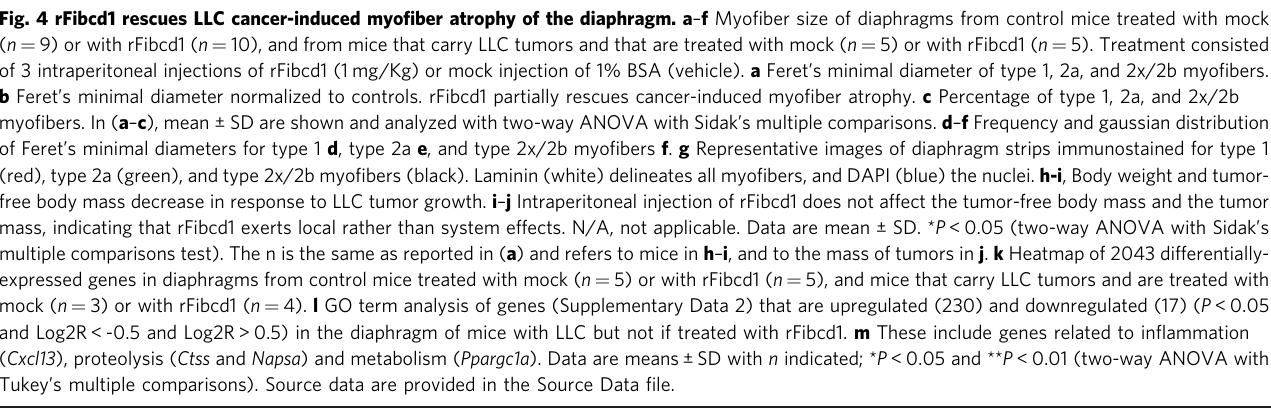
Fig. 4 rFibcd1 rescues LLC cancer-induced myo fi ber atrophy of the diaphragm. a – f Myo fi ber size of diaphragms from control mice treated with mock ( n = 9) or with rFibcd1 ( n = 10), and from mice that carry LLC tumors and that are treated with mock ( n = 5) or with rFibcd1 ( n = 5). Treatment consisted of 3 intraperitoneal injections of rFibcd1 (1 mg/Kg) or mock injection of 1% BSA (vehicle). a Feret ’ s minimal diameter of type 1, 2a, and 2x/2b myo fi bers. b Feret ’ s minimal diameter normalized to controls. rFibcd1 partially rescues cancer-induced myo fi ber atrophy. c Percentage of type 1, 2a, and 2x/2b myo fi bers. In ( a – c ), mean ± SD are shown and analyzed with two-way ANOVA with Sidak ’ s multiple comparisons. d – f Frequency and gaussian distribution of Feret ’ s minimal diameters for type 1 d , type 2a e , and type 2x/2b myo fi bers f . g Representative images of diaphragm strips immunostained for type 1 (red), type 2a (green), and type 2x/2b myo fi bers (black). Laminin (white) delineates all myo fi bers, and DAPI (blue) the nuclei. h-i , Body weight and